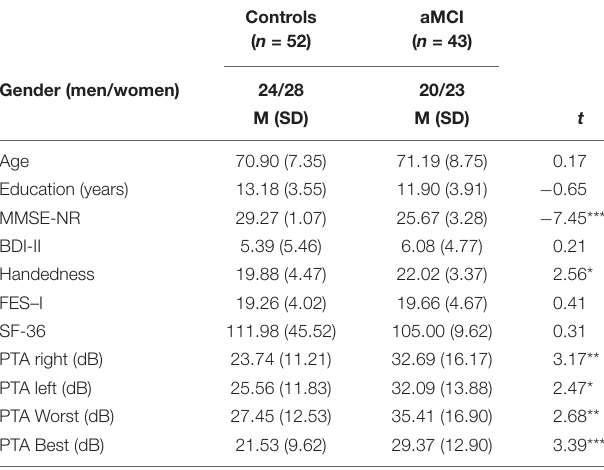
TABLE 1 | Demographic characteristics and initial assessments by group.